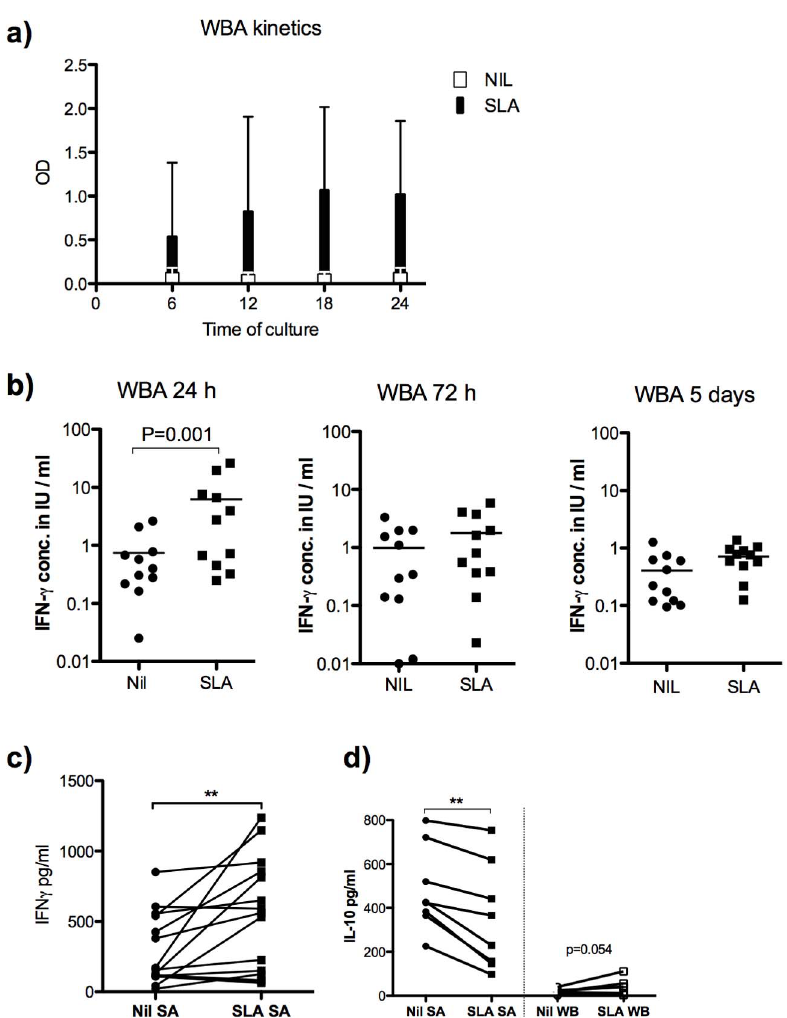
Figure 1. Induction of IFN c in SLA stimulated whole blood and splenic aspirates from patients with active VL. a) IFN c in SLA stimulated (black bars) and unstimulated (white bars) WB during the first 24 hours of culture and b) IFN c production (measured in units by QuantiFeron kit) in culture supernatants from SLA stimulated WB after 24 hours, 72 hours and 5 days incubation at 37 u C, 5%CO 2 . c) IFN c in 24 hour cultures of SLA stimulated and unstimulated SA from patients with active VL (n=15) and d) IL-10 in 24-hour SLA stimulated and unstimulated SA (left) and WB (right), n=8. Results show in a mean OD + SD of the samples tested, in b–d one dot represents one sample. Stimulated and unstimulated samples were compared by Wilcoxon matched paired test and statistical significances are indicated with *** p , 0.001, ** p , 0.01 and * p , 0.05.